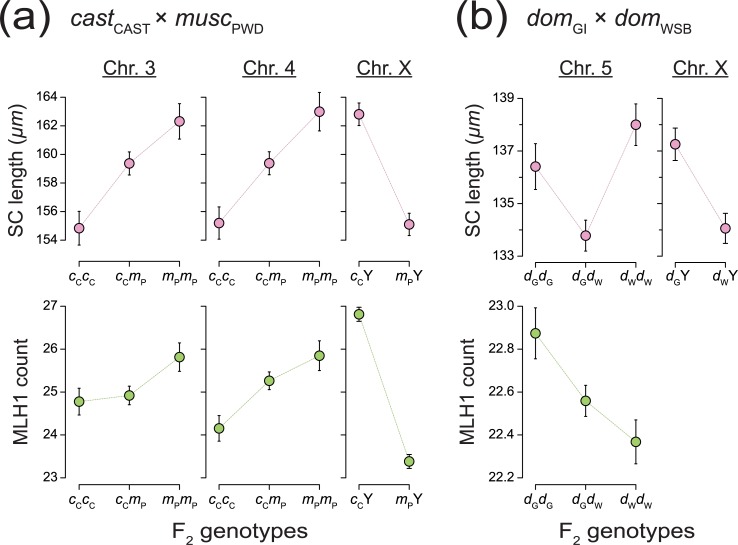
Estimated QTL effects by genotype.Effects on F2 individuals estimated at the position of peak LOD on chromosomes with significant QTL for mean SC length (top) and MLH1 foci count (bottom). Error bars show ±1 SE.(a) castCAST × muscPWD cross; cC – castCAST, mP−muscPWD SC QTL: (Chr. 3, 38.0 cM); (Chr. 4, 44.0 cM); (Chr. X, 31.9 cM) MLH1 QTL: (Chr. 3, 66.0 cM); (Chr. 4, 25.0 cM); (Chr. X, 31.9 cM) (b) domGI × domWSB cross; dG−domGI, dW−domWSB SC QTL: (Chr. 5, 44.8 cM); (Chr. X, 54.0 cM) MLH1 QTL: (Chr. 5, 36.9 cM).